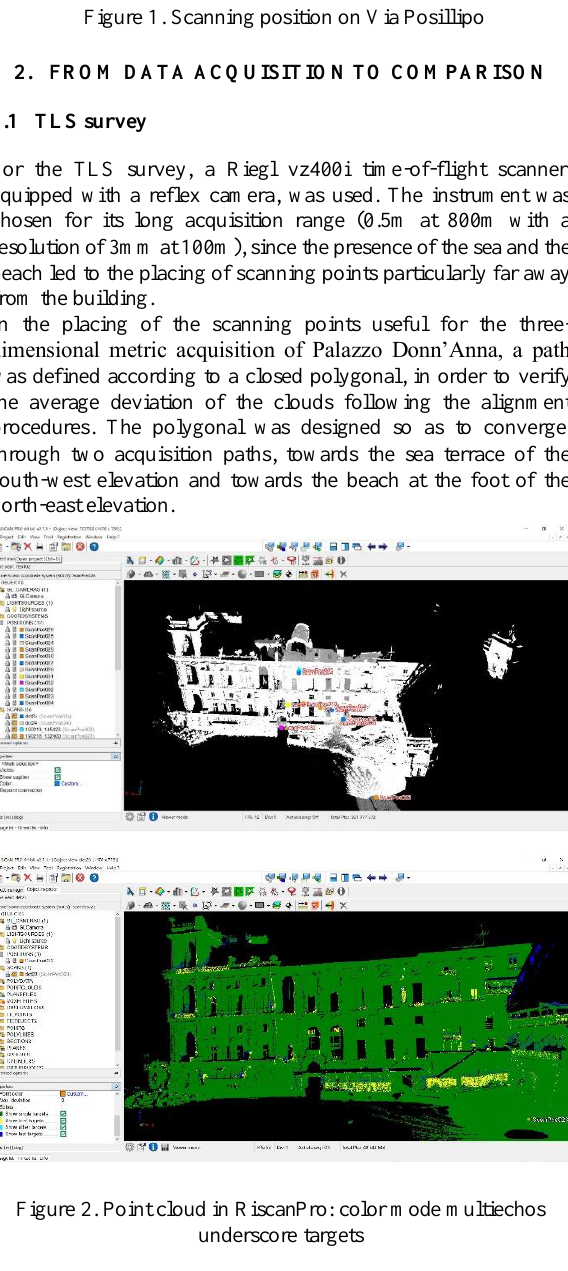
Figure 1. Scanning position on Via Posillipo